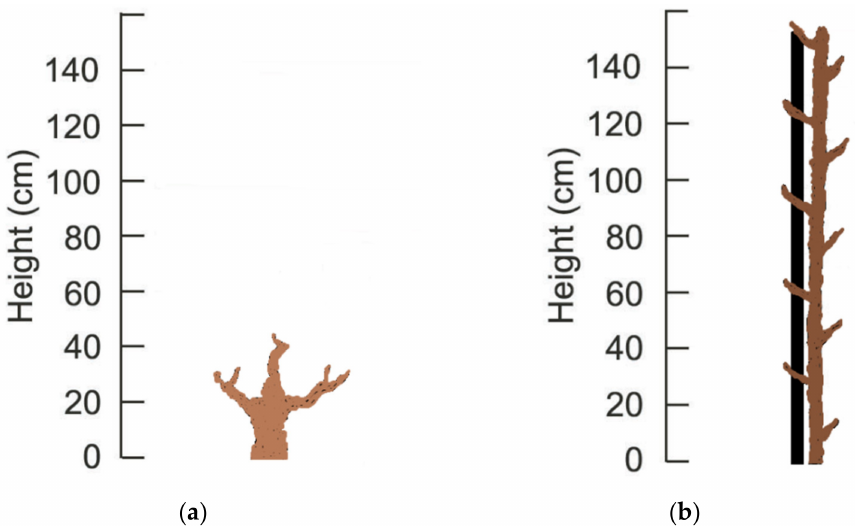
Figure 1. Representations of training systems. ( a ) Head-trained vine (gobelet); ( b ) vertical cor- don